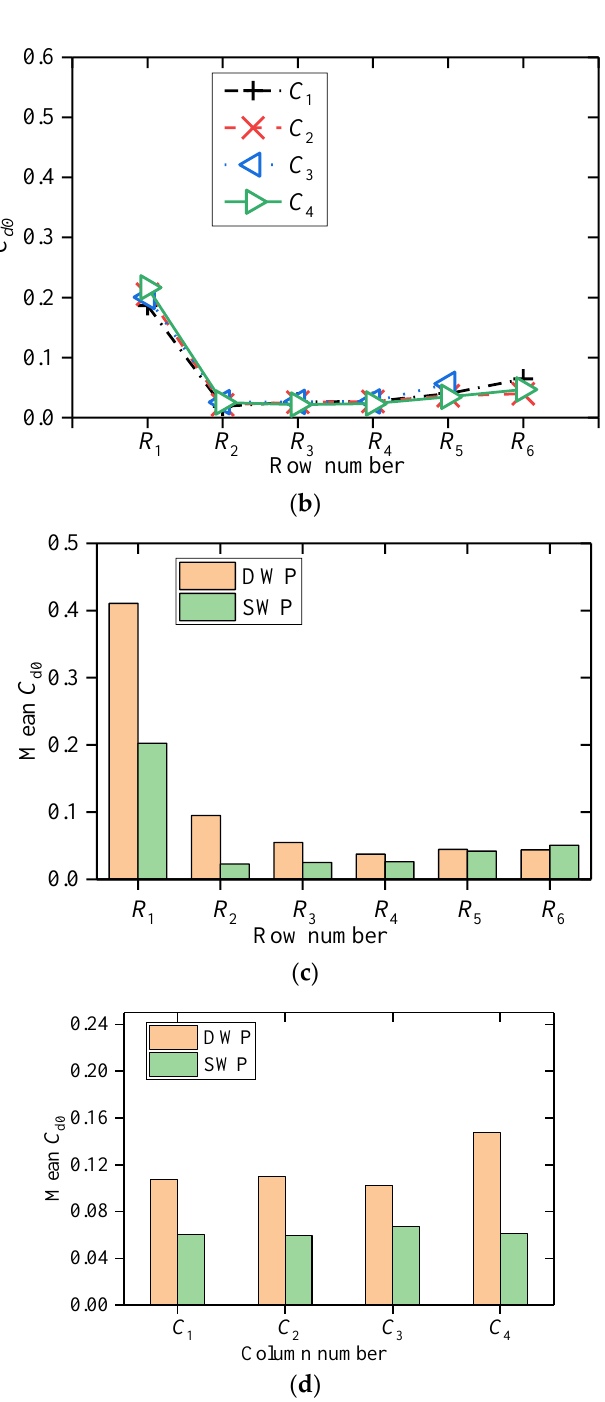
Figure 19. LES results of C d0 for ( a ) DWP, (b) SWP, ( c ) mean C d0 for all the individual buildings in each row, and ( d ) mean C d0 for all the individual buildings in each column.